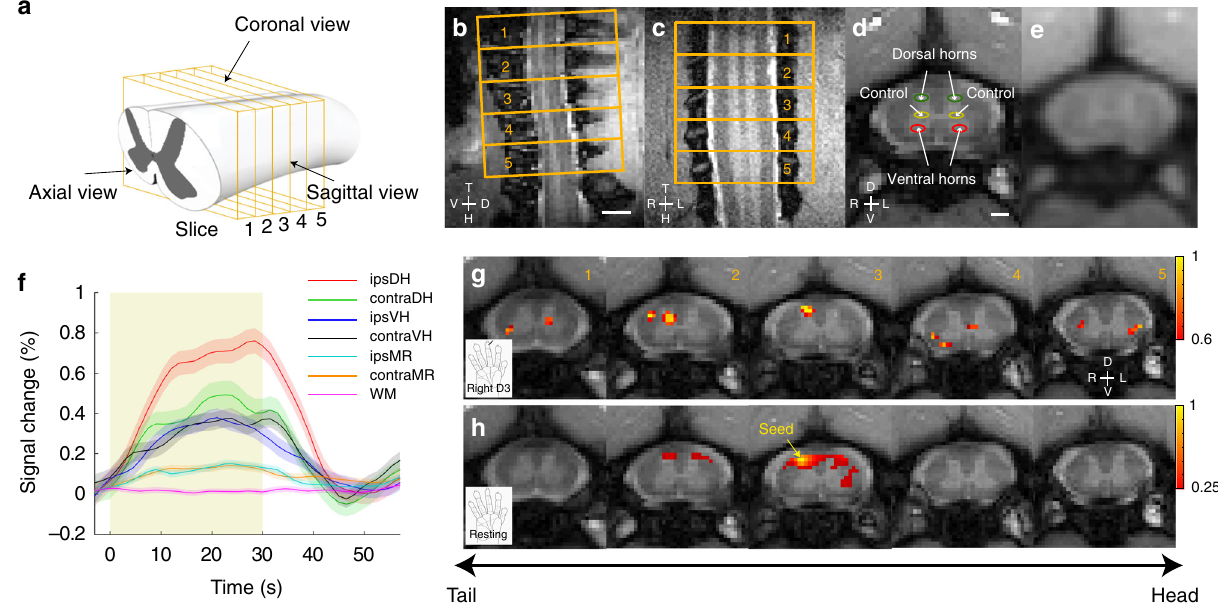
Fig. 1 Stimulus-driven and resting-state fMRI in non-human primates at 9.4 T. a Schematic diagram (modi fi ed from Hollis et al. 55 ) of imaging planes of the spinal cord. b Sagittal and ( c ) coronal views of the spinal cord in magnetization transfer contrast (MTC) images. Scale bar represents 3 mm. ( d ) MTC and ( e ) BOLD-sensitive axial images. Scale bar represents 1 mm. Red and green circles indicate dorsal and ventral horns, respectively. Yellow circles present intermediate gray matter of the spinal cord used as controls for later quanti fi cations. f Group-averaged ( N = 7 monkeys) BOLD signal changes in the four horns — dorsal horn (DH) and ventral horn (VH) — of the spinal cord and middle/intermediate gray matter regions (MR) that are ipsilateral (ipsi) and contralateral (contra) to the stimulus, as well as white matter (WM) control region. Shaded error bars represent standard error of mean. g Multirun activation map to D3 tactile stimulation thresholded at 0.6 of normalized percentage signal, with a peak value of 1. h Multirun resting-state connectivity patterns (thresholded at r > 0.25) of a seed from one representative monkey. D dorsal, V ventral, H head, T